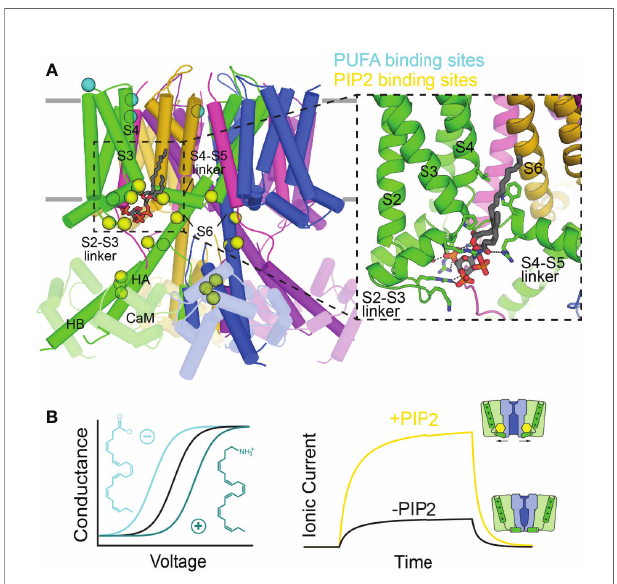
FIGURE 8 | Binding sites of lipids on the KCNQ1 channel. (A) Mapping of positions that have been implicated in the regulation of KCNQ1 by PUFAs (cyan) and PIP 2 (yellow) onto the PIP 2 -bound KCNQ1 structure (6V01) (Sun and Mackinnon, 2020). Inset: the PIP 2 cryo-EM binding site. (B) Left: Effect of the PUFA head group charge on the voltage dependence of KCNQ1 conductance (inspired from results in Liin et al., 2015). Right: PIP 2 depletion reduces KCNQ1 ionic currents due to decreased VSD-PD